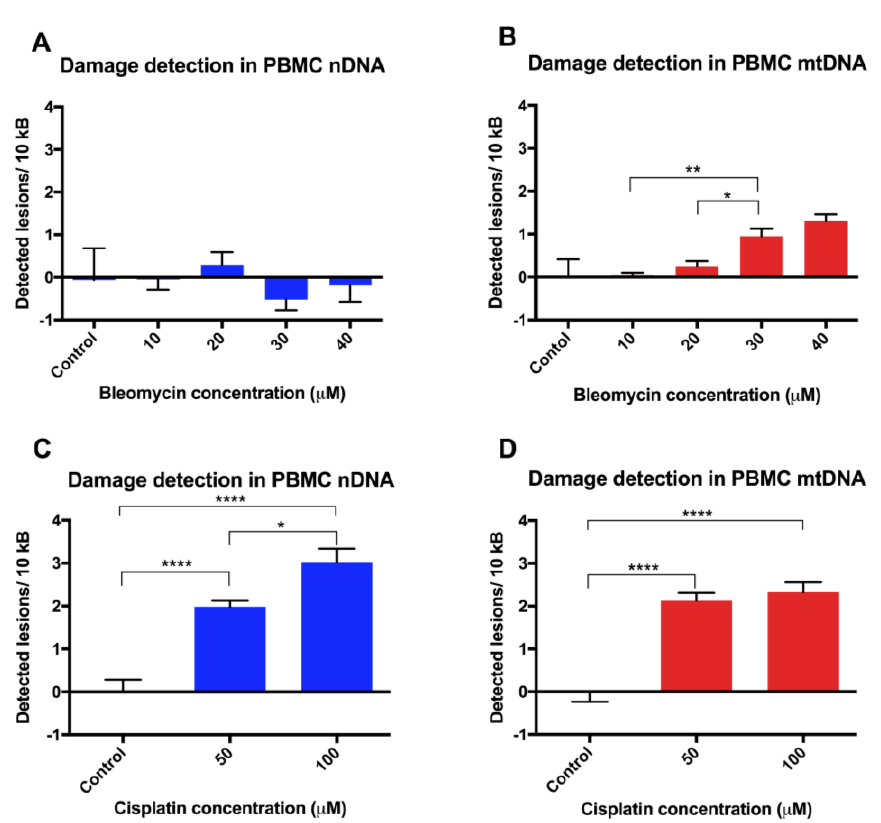
Figure 4. Cytotoxic chemotherapy-induced DNA damage in PBMCs. Quantitation of DNA lesion rates in revived PBMCs in ( A ) nDNA and ( B ) mtDNA following exposure to bleomycin or in ( C ) nDNA and( D ) mtDNA following exposure to cisplatin ( n = 6). Results are presented as mean ± SE. * p < 0.05, ** p < 0.01, *** p < 0.001, **** p < 0.0001.